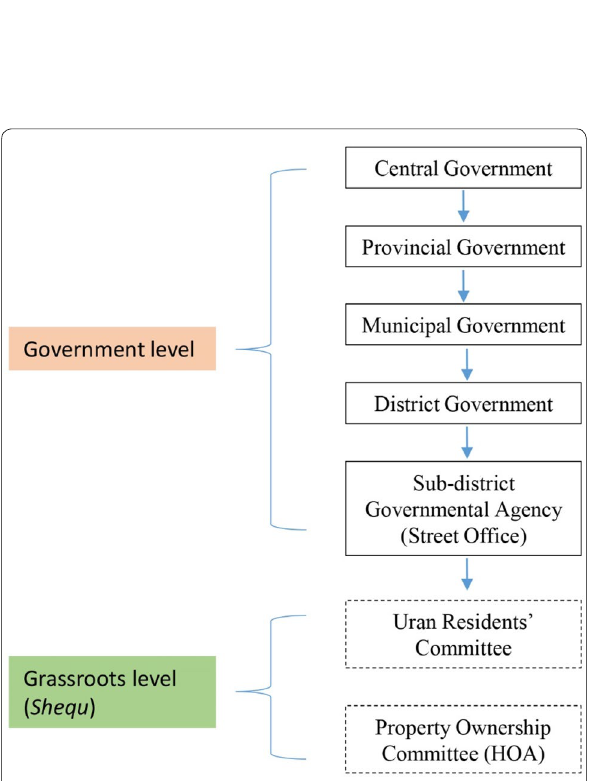
Fig. 5 The hierarchical administrative structure in China (Source: by the